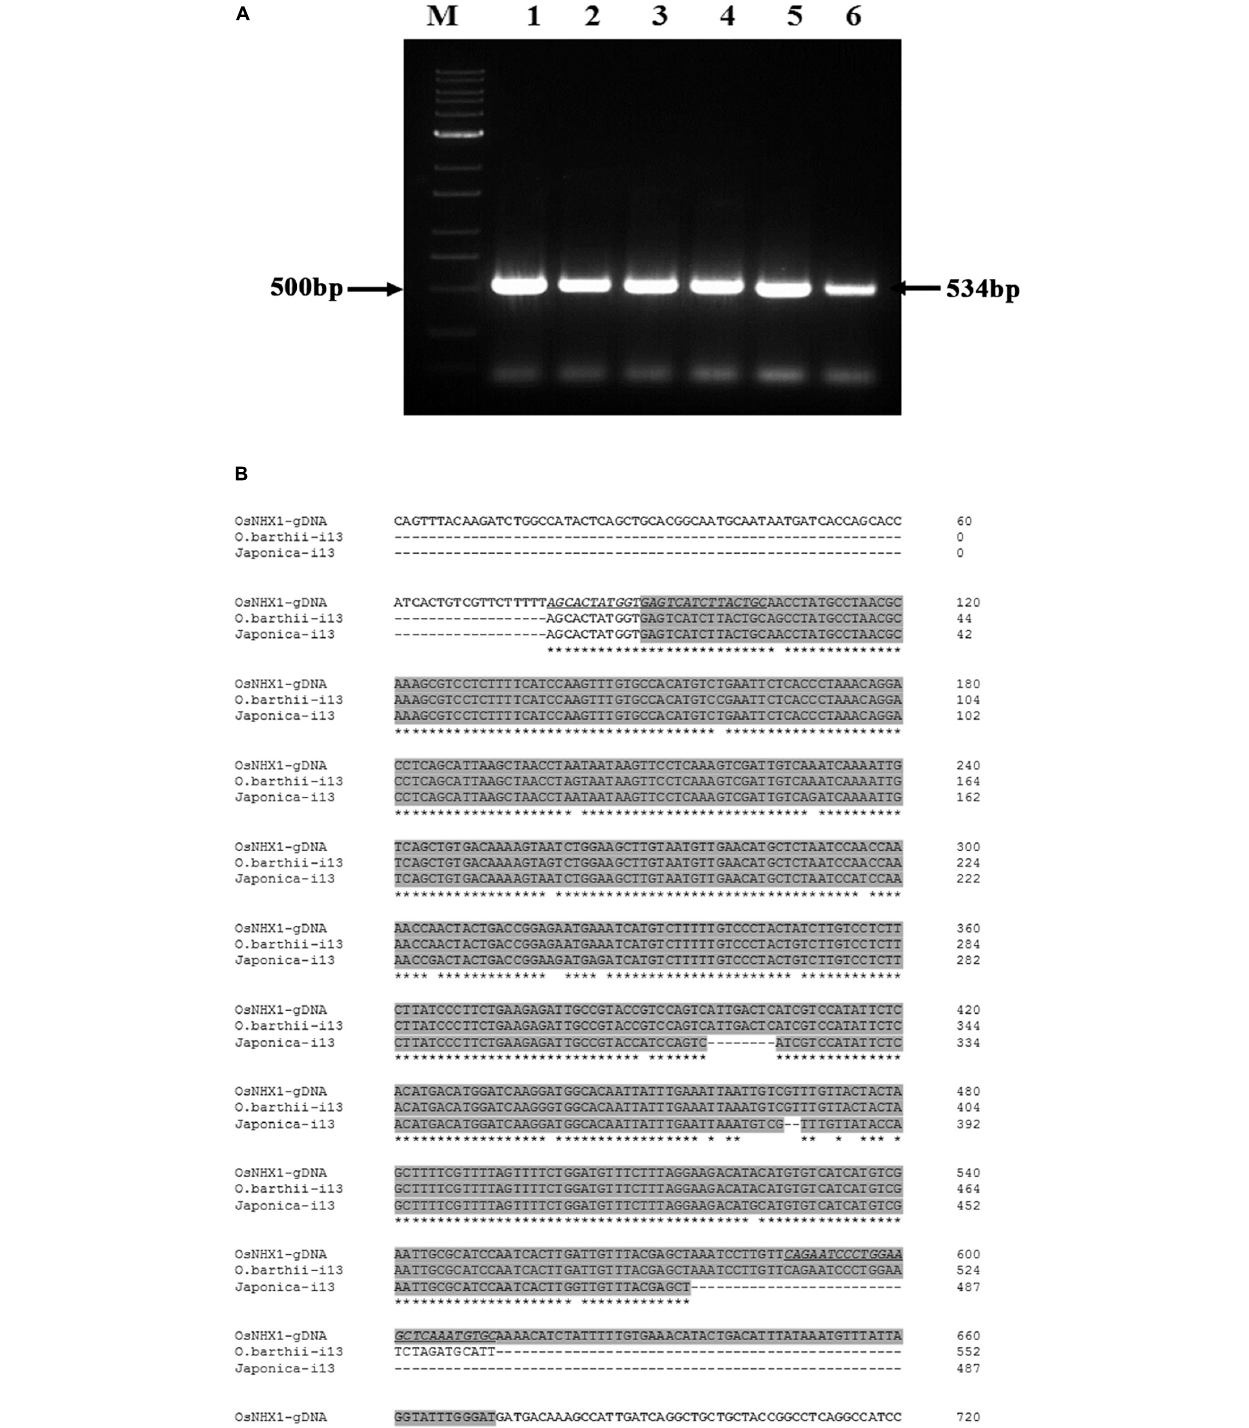
Frontiers in Plant Science |